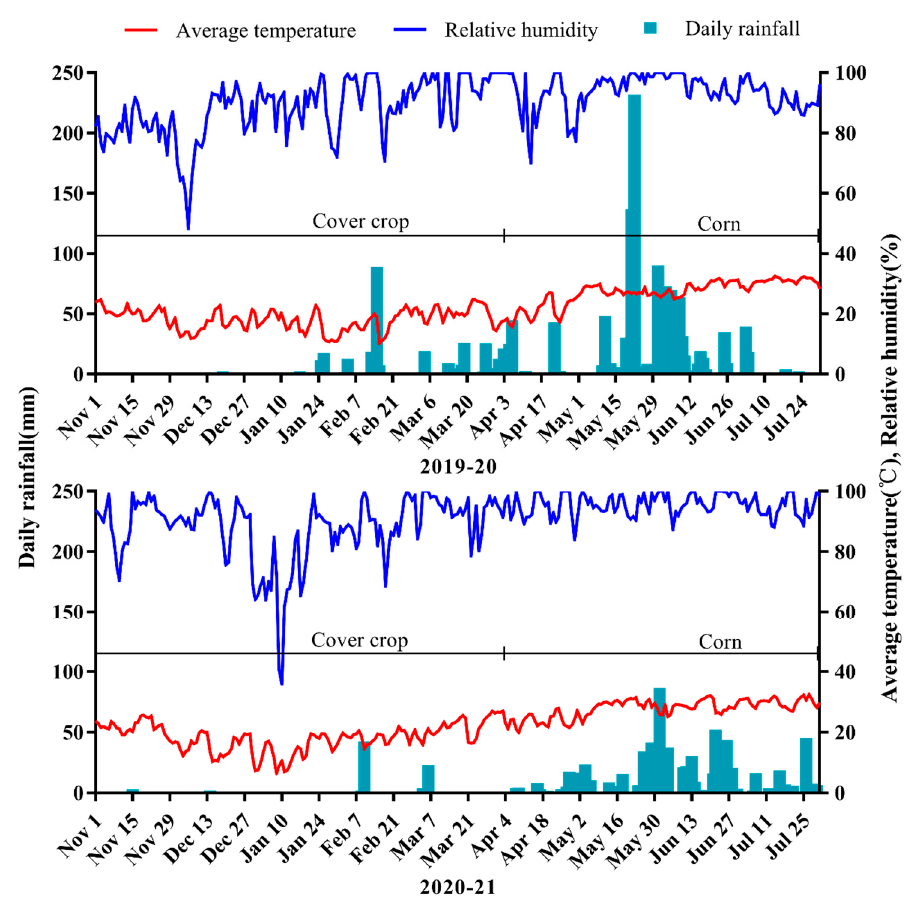
Figure 1. Weather data of the experimental site during cropping seasons of both